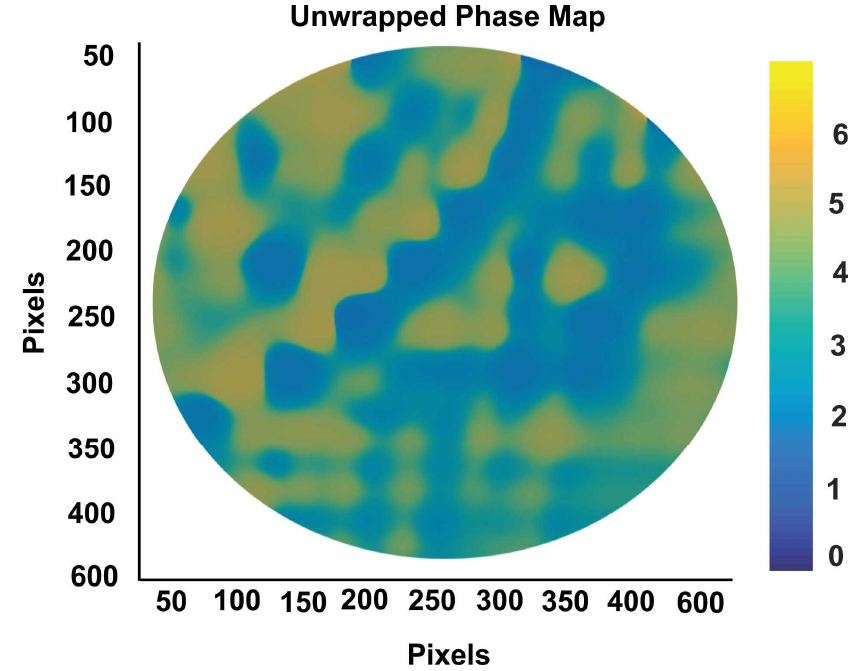
Figure 12. Dynamic phase object. Representative frames (Supplementary Video S1 ).